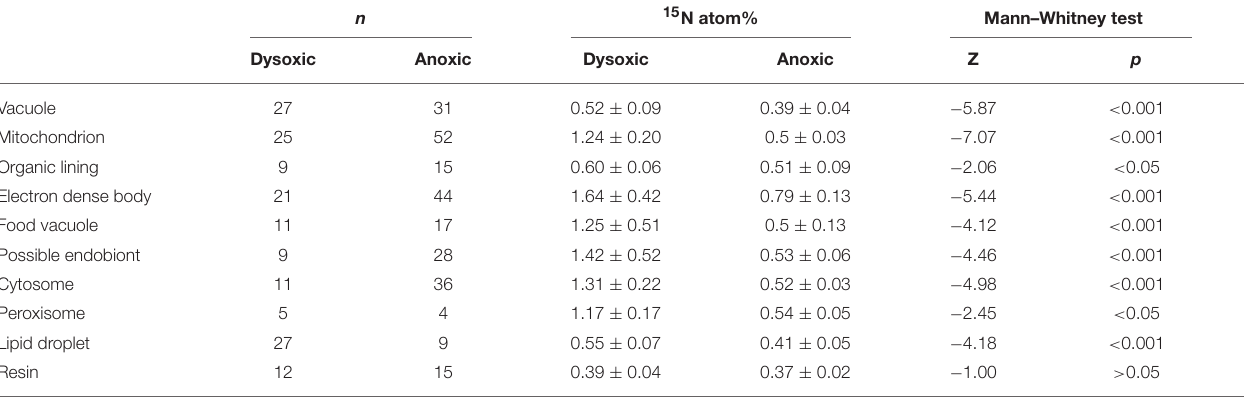
TABLE 1 | Results of Mann–Whitney test of 15 N atom% between dysoxic and anoxic conditions. n 15 N atom%